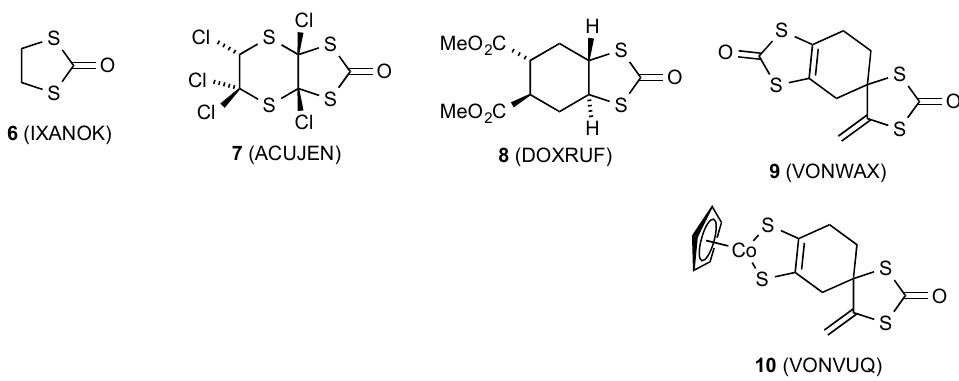
Figure 2. Unit cell of 1 viewed along the c -axis showing the four molecules present.